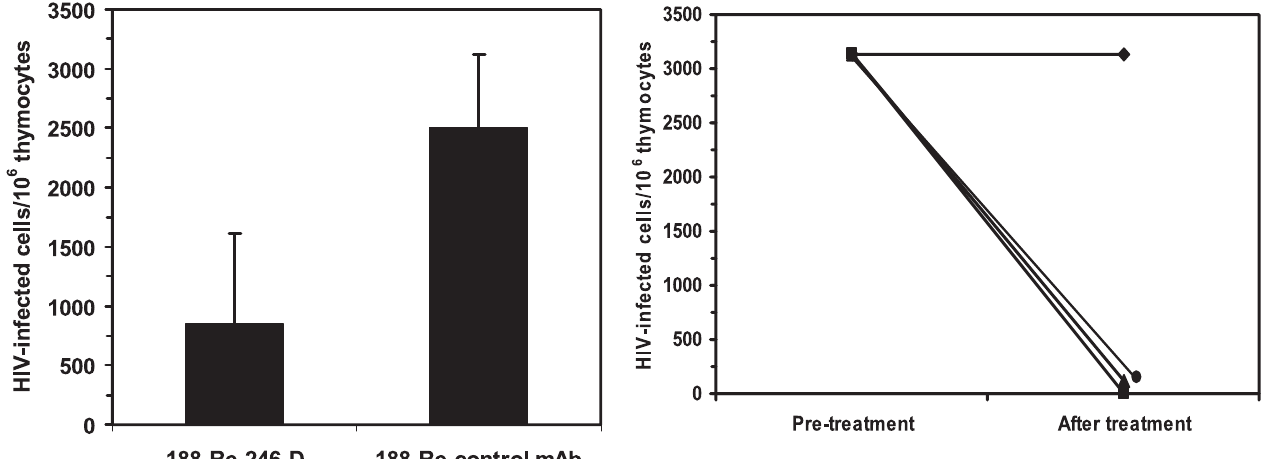
Figure 5. RIT Using Anti-gp41 mAb 188 Re-246-D Reduces HIV Infection in the Human Thymic Implants of thy/liv-SCID-hu Mice One week after thy/liv-SCID-hu mice were infected with HIV-1, they were treated by intraimplant injection of two doses of either 188 Re-246-D ( n ¼ 4) or 188 Re-1418 control mAb ( n ¼ 4) given on two consecutive days ( p ¼ 0.11). (A) The number of HIV-infected thymocytes was determined 3 d later. The bars show mean number (error bars show standard error of the mean) of HIV- infected thymocytes/10 6 thymocytes in the human thymic implants of thy/liv-SCID-hu mice treated with 188 Re-246-D or 188 Re-1418 control mAb. (B) Comparison of the number of HIV-infected thymocytes in the human thymic implants in each of the four treated thy/liv-SCID-hu mice before treatment was initiated and after treatment with 188 Re-246-D.